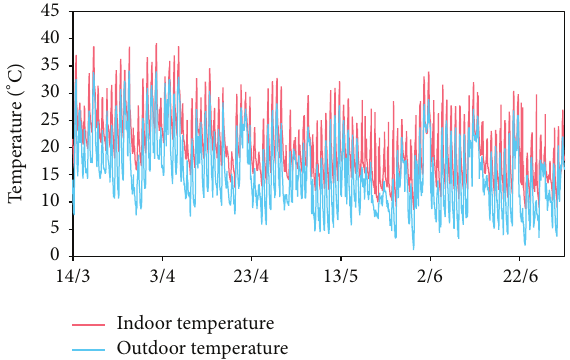
Figure 4: The response of the indoor and outdoor temperature